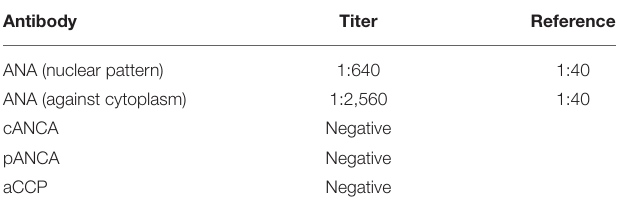
TABLE 2 | Pharmacological treatment during fourth psychiatric